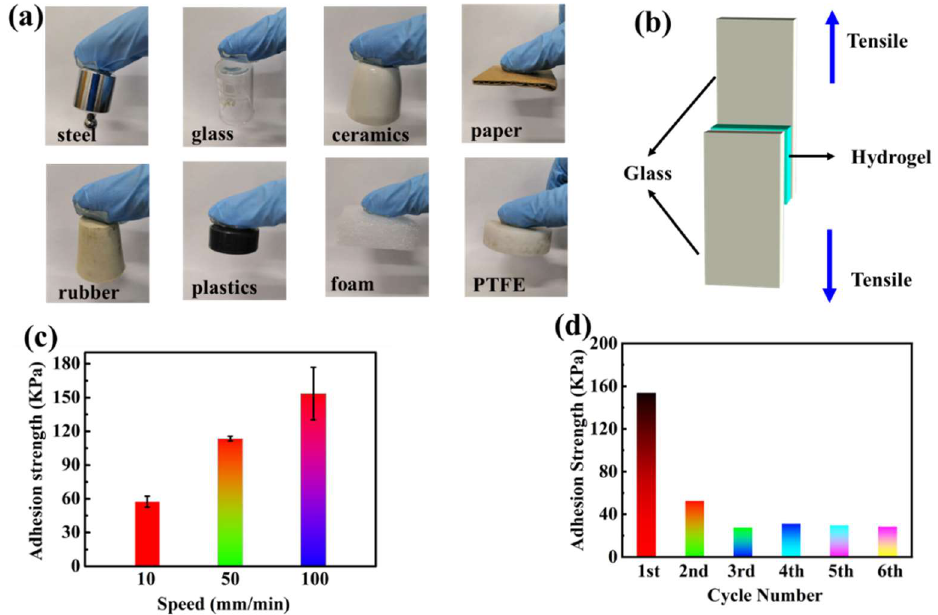
Figure 3. ( a ) LiCl/p(HEAA− co −BD) hydrogels adhere to different substrates; ( b ) Schematic diagram of lap shear testing for strip strength; ( c ) Effect of peel speed on adhesion strength of hydrogels; ( d ) multiple adhesion of hydrogels.